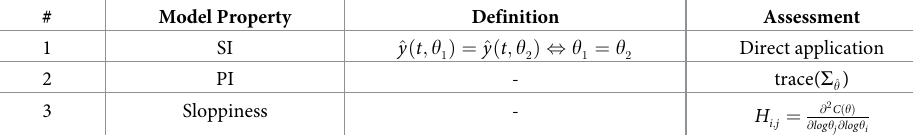
Table 1. List of model properties and their definitions.